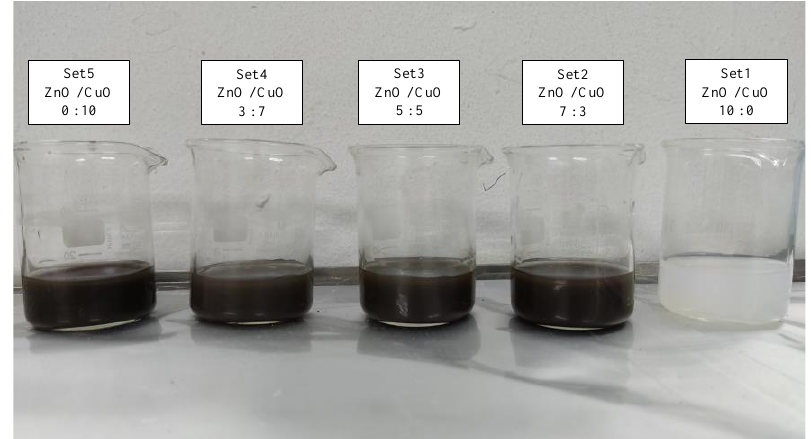
Figure 2. Samples of prepared hybrid nanofluids.